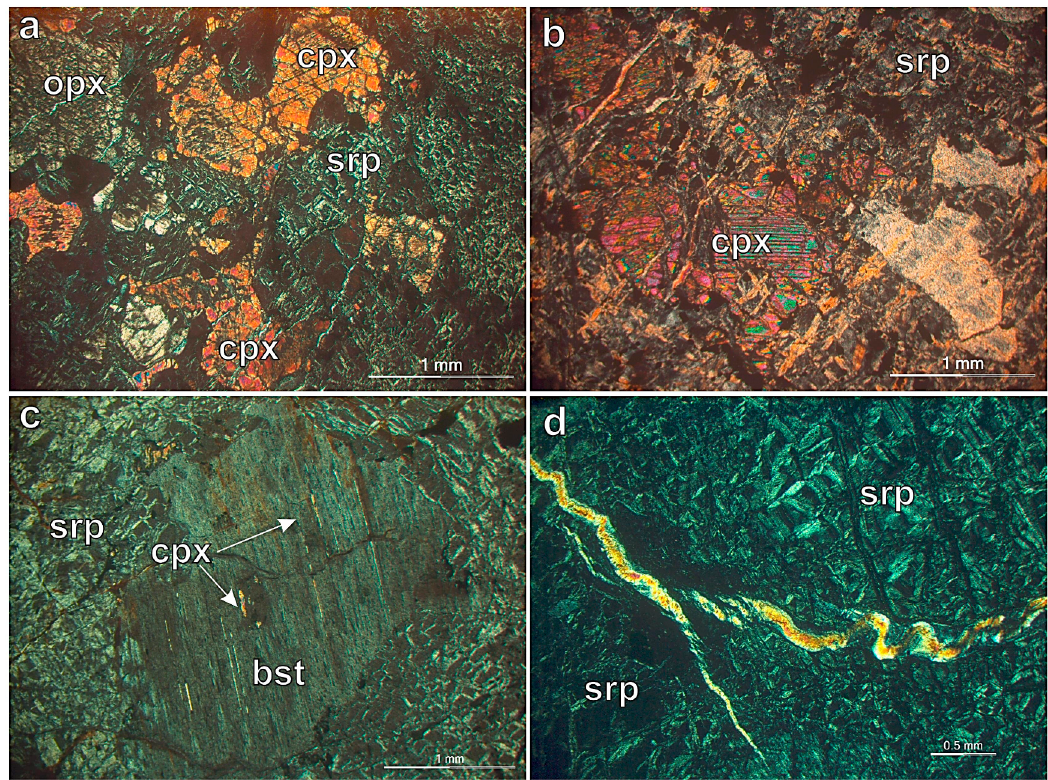
Figure 2. Photomicrographs of serpentinites showing ( a ), ( b ) relics of orthopyroxene and clinopyroxene in serpentinised matrix (sample BE.01, XPL); ( c ) bastite orthopyroxene porphyroclast with exsolution lamellae of clinopyroxene (sample BE.133, XPL); ( d ) mesh texture of serpentinised matrix with intragranular microcracks partially filled with serpentine as well (sample BE.103, XPL). Abbreviations: opx: orthopyroxene, cpx: clinopyroxene, srp: serpentine, bst: